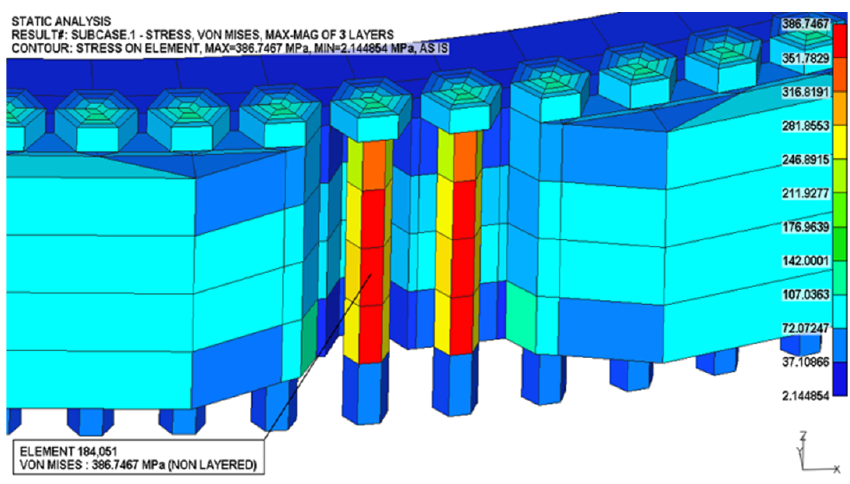
Figure 18. Maximum equivalent stress at bolt (Close-up). The results showed that the von Mises stresses of bolts on the 12 analysis cases were under the allowable stress (830 MPa) of the bolt as shown in Table 17. Table 17. Maximum equivalent stresses of bolts.